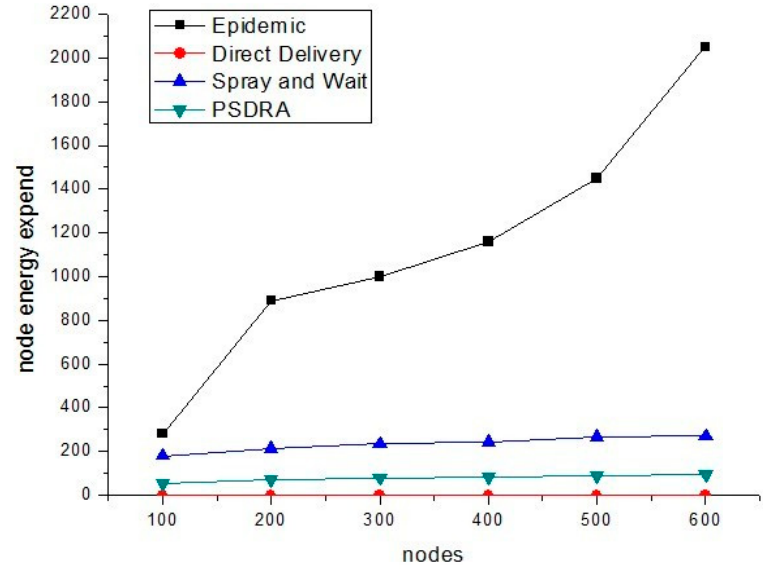
Figure 4. The expended node energy.